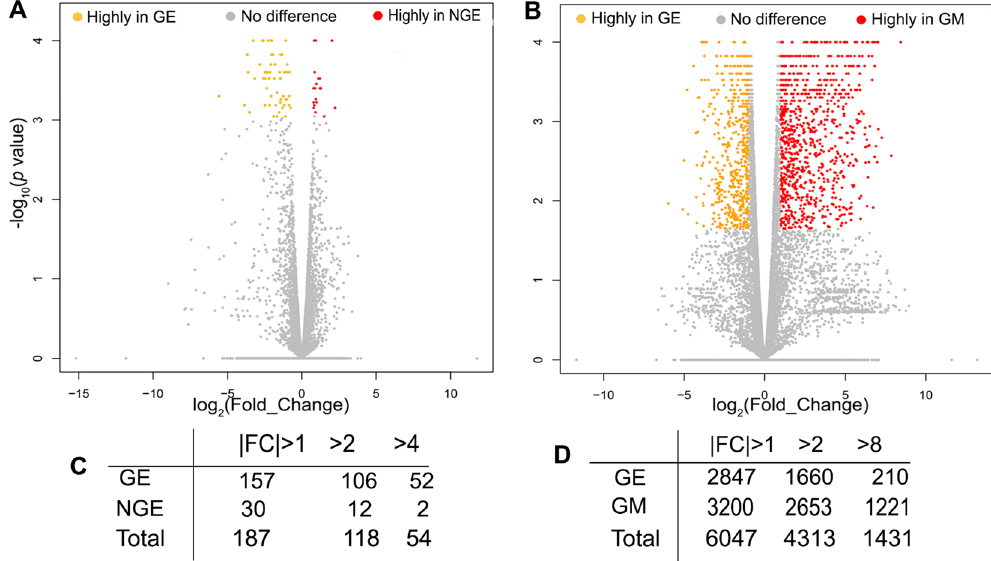
Figure 2. Volcano plots ( A , B ) and number of highly expressed DEGs at different fold changes (FC) ( C , D ) to display the DEGs in the GE vs NGE ( A , C ) and GE vs GM ( B , D ) in the base of oral cavity of P3 male chickens. In A and B, the Y-axis corresponds to the mean expression value of log10 ( p -Value), and the X-axis displays the log2 (Fold_Change). The orange and red dots represent highly expressed genes in the GE ( A , B ) or NGE ( A ) or GM ( B ) ( p < 0.05, FDR q < 0.05); the gray dots represent the transcripts whose difference of expression levels did not reach statistical significance ( p > 0.05, FDR q > 0.05). GE: gustatory epithelium; NGE: non-gustatory epithelium; GM: gustatory